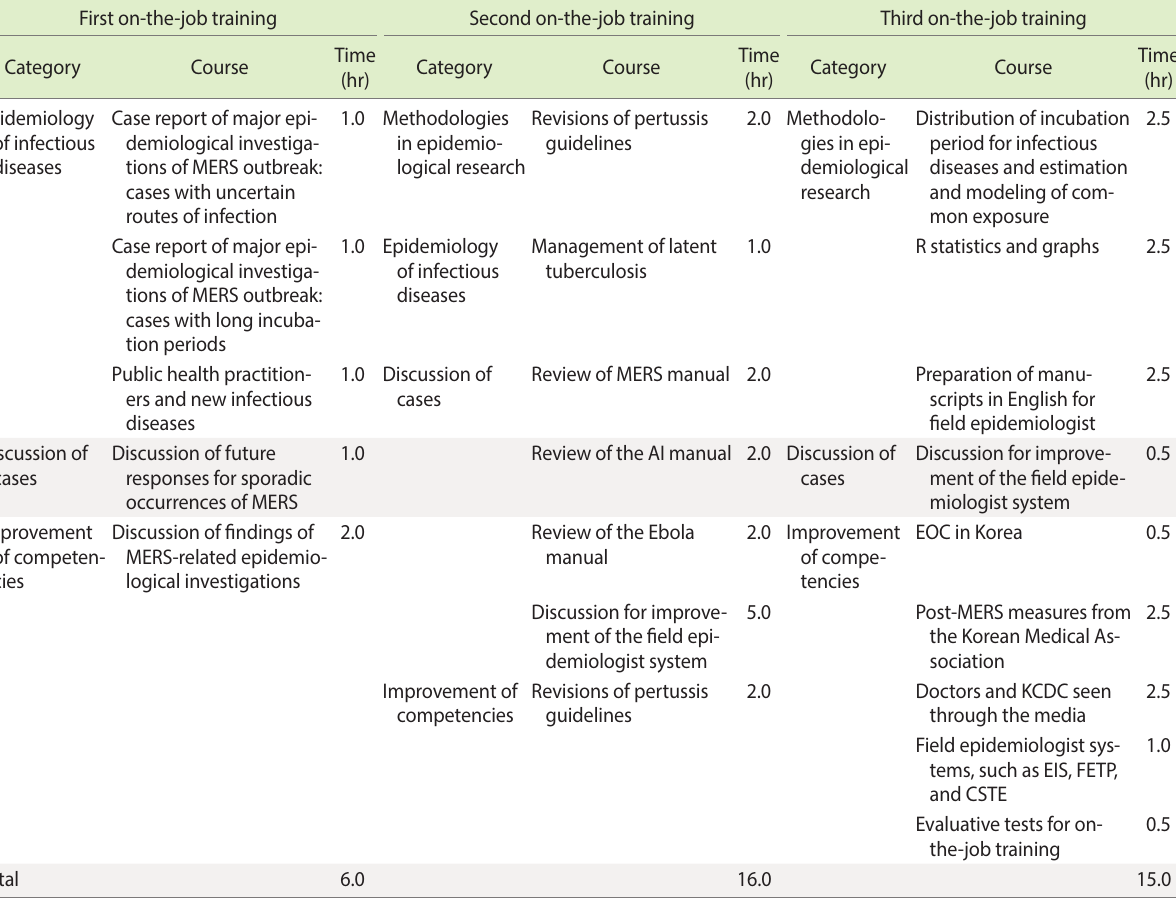
Table 4. Courses and time spent for training during on-the-job training for field epidemiologists in 2015 First on-the-job training